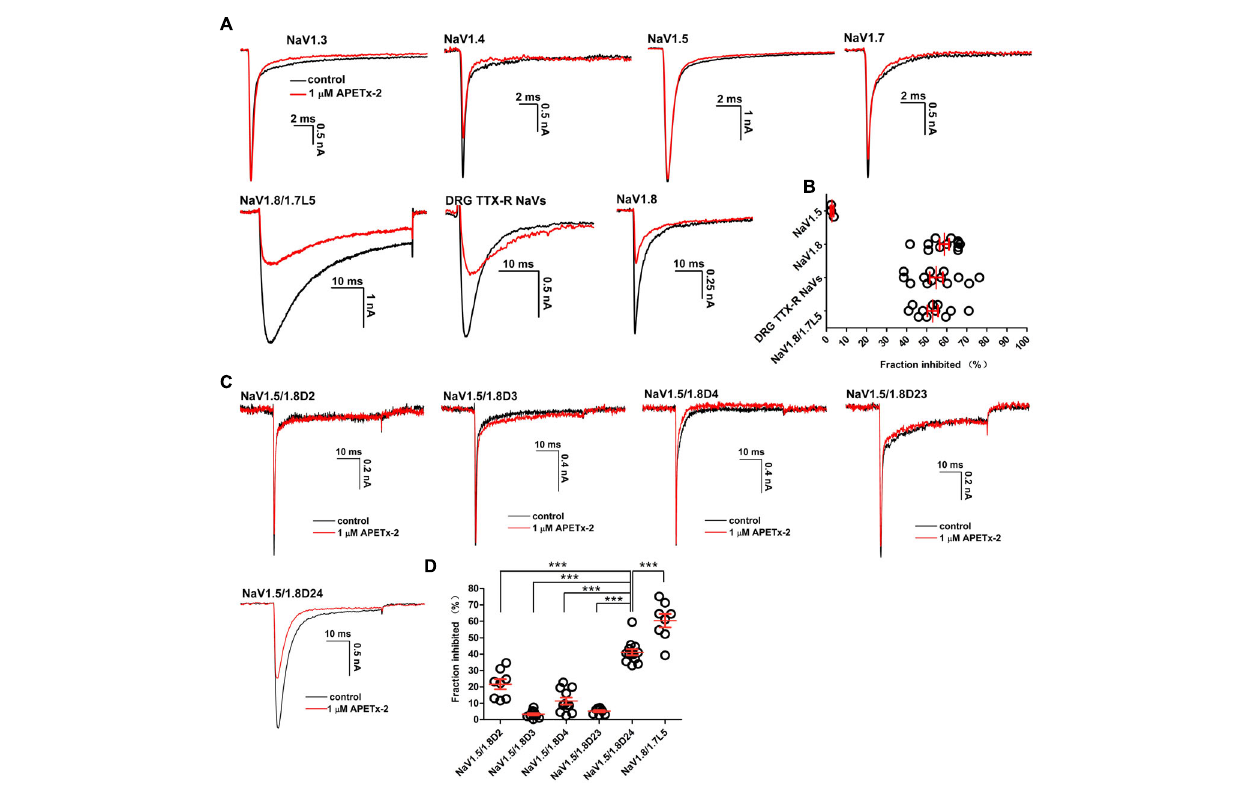
FIGURE 5 | Mechanism of APETx-2 interacting with NaV1.8. (A) Representative traces showed the effects of APETx-2 on NaVs. NaV1.8/1.7L5, DRG TTX-R NaVs and NaV1.8 were much more susceptive to APETx-2 than NaV1.3 – 1.5 and NaV1.7. (B) Comparison of the inhibitory effect of 1 µ M APETx-2 on channels as shown, a dot indicated the inhibition ratio from one tested cell, the ratio was 2.8 ± 0.5%, 58.8 ± 2.3%, 54.7 ± 3.3%, and 53.0 ± 2.7% for NaV1.5, NaV1.8, DRG TTX-R NaVs and NaV1.8/1.7L5, respectively. The differences were not significant between NaV1.8, DRG TTX-R NaVs and NaV1.8/1.7L5 ( p > 0.05, ONE-WAY ANOVA, n = 11 – 13). (C) Representative traces showed the effect of APETx-2 on chimeras as shown, NaV1.5/1.8D24 was potently inhibited by 1 µ M toxin. (D) 1 µ M APETx-2 blocked NaV1.5/1.8D2, NaV1.5/1.8D3, NaV1.5/1.8D4, NaV1.5/1.8D23, NaV1.5/1.8D24 and NaV1.8/1.7L5 currents by 21.7 ± 3.1%, 3.3 ± 0.7%, 11.4 ± 2.1%, 5.2 ± 0.7%, 41.1 ± 1.9% and 60.0 ± 4.0%, respectively. The differences between NaV1.5/1.8D24 and other channels (NaV1.5/1.8D2, NaV1.5/1.8D3, NaV1.5/1.8D4, NaV1.5/1.8D23, and NaV1.8/1.7L5) were significant ( p < 0.001, ONE-WAY ANOVA, n = 8 – 13). Unless otherwise indicated,